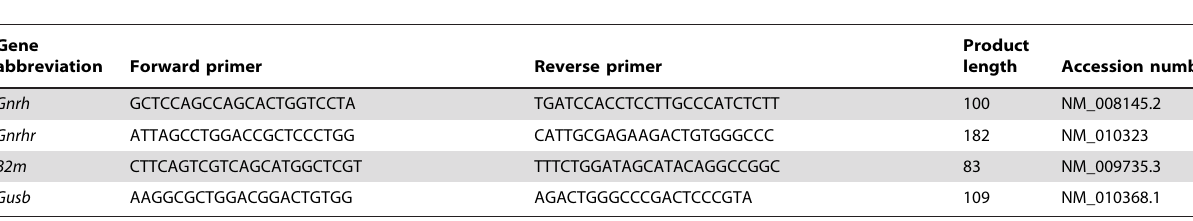
Table 2. Primer sequences for target and reference genes used in the